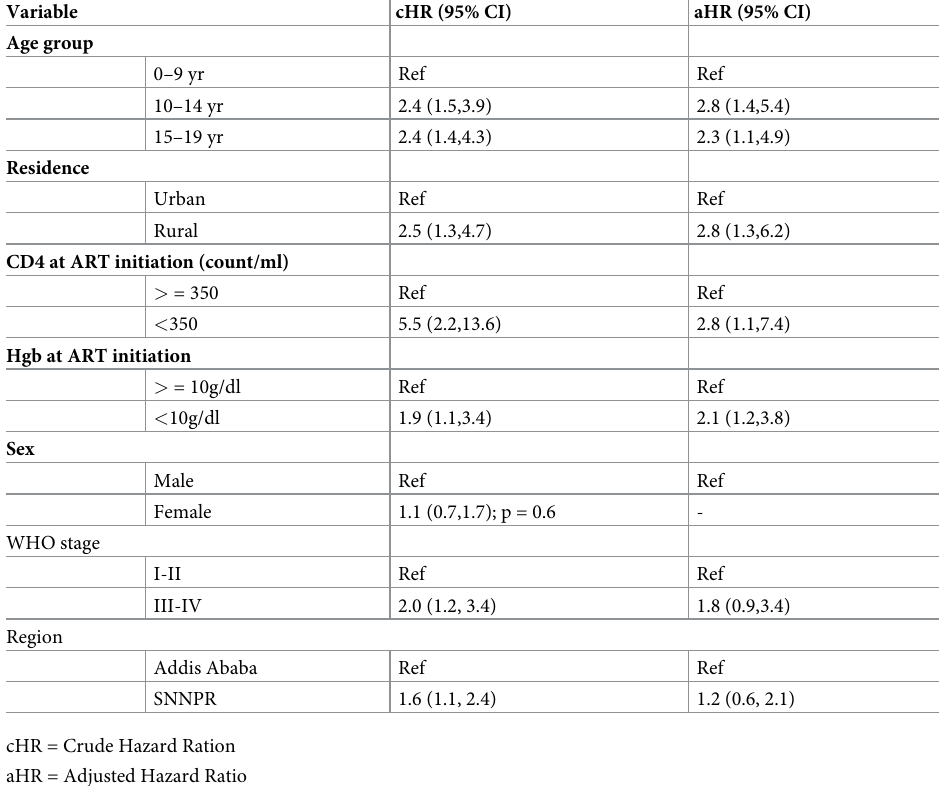
Table 4. Predictors of post-ART mortality according to Cox regression